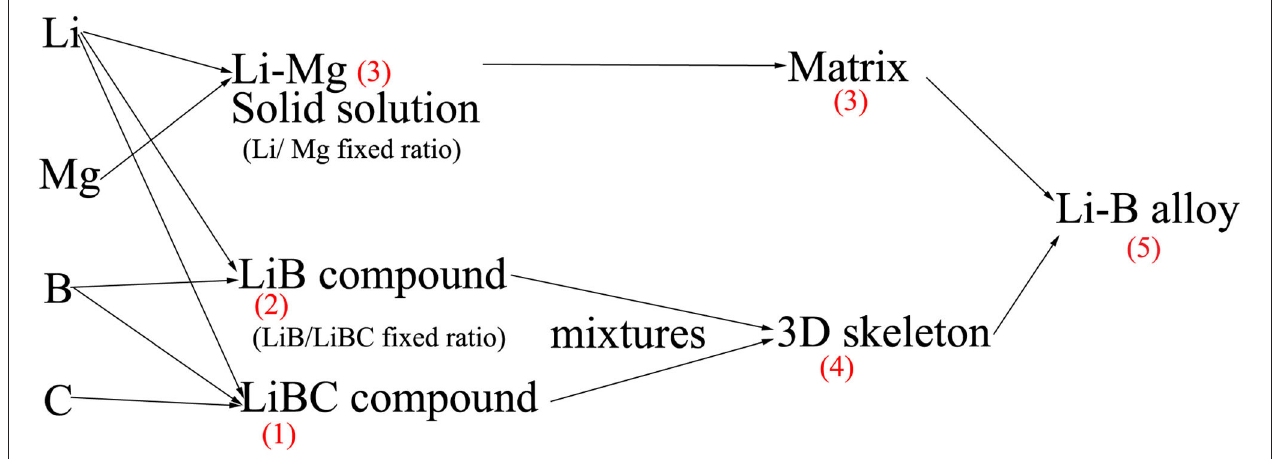
FIGURE 5 | Overview of stepwise formation process of Li-B alloy.